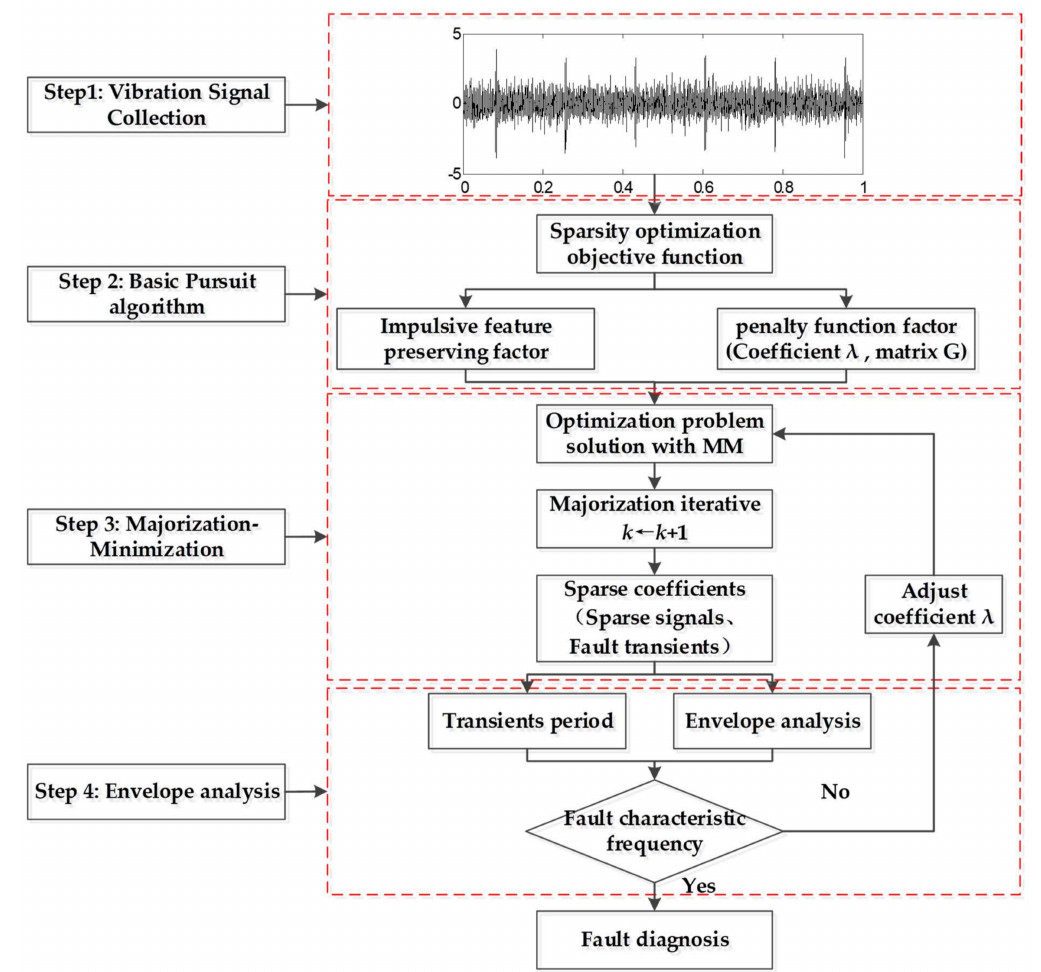
Figure 3. Feature enhancing algorithm framework based on